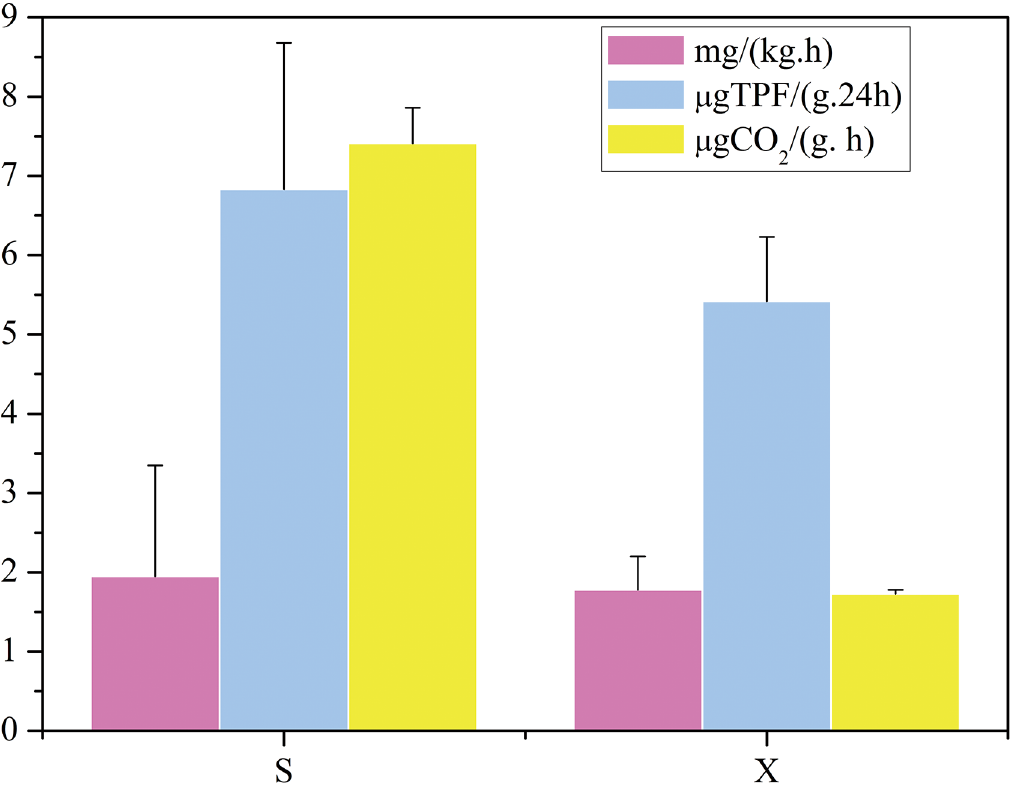
Fig 3. Soil microbial respiration (SMR), Dehydrogenase (DHA) and glycosidase (Gly) in Shang shoal and Xia shoal. S1~S3: three samples in Shang shoal, X1~X3: three samples in Xia shoal. Different capital letters (A, B) above the error bar represent significant difference between two areas at the 0.01 level. * The values were averaged by all sites in four seasons in each zone.